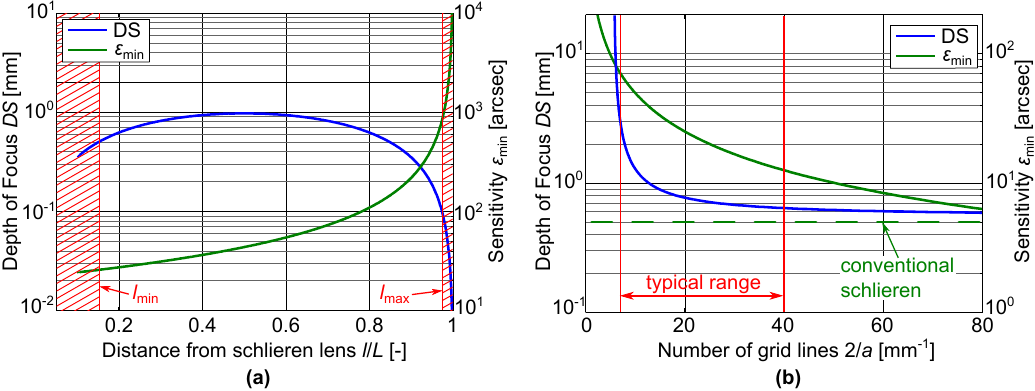
Figure 3. Influence of design parameters on system properties. Depth of focus DS and sensitivity (cid:101) min as function of ( a ) distance of plane of focus to schlieren lens and ( b ) number of grid lines.